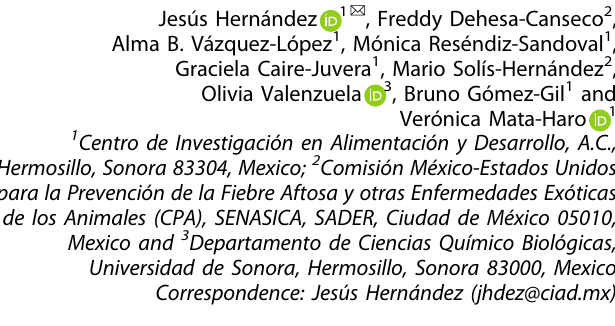
Fig. 1 Neutralizing response against the ancestral strain and Omicron BA.1, BA.5.1.6, BQ.1.3, and XBB.1 subvariants induced by Ad5-nCoV and a heterologous immunization of Ad5-nCoV and mRNA-1273. a Neutralizing antibodies (nAbs) against the ancestral strain and BA.1, BA.5.1.6, BQ.1.3, and XBB.1 of samples from individuals vaccinated with Ad5-nCoV. The p values (two-sided) for group comparison of GMT are as follows: ancestral strain versus BA.1, BA.5.1.6, BQ.1.3, and XBB.1: all <0.0001. b nAbs against the ancestral strain and Omicron BA.1, BA.5.1.6, BQ.1.3, and XBB.1 subvariants of samples from individuals nonpreviously infected and previously infected vaccinated with Ad5-nCoV. The p values (two-sided) for group comparison of GMT are as follows: ancestral strain versus BA.1, BA.5.1.6, BQ.1.3, and XBB.1 (in both